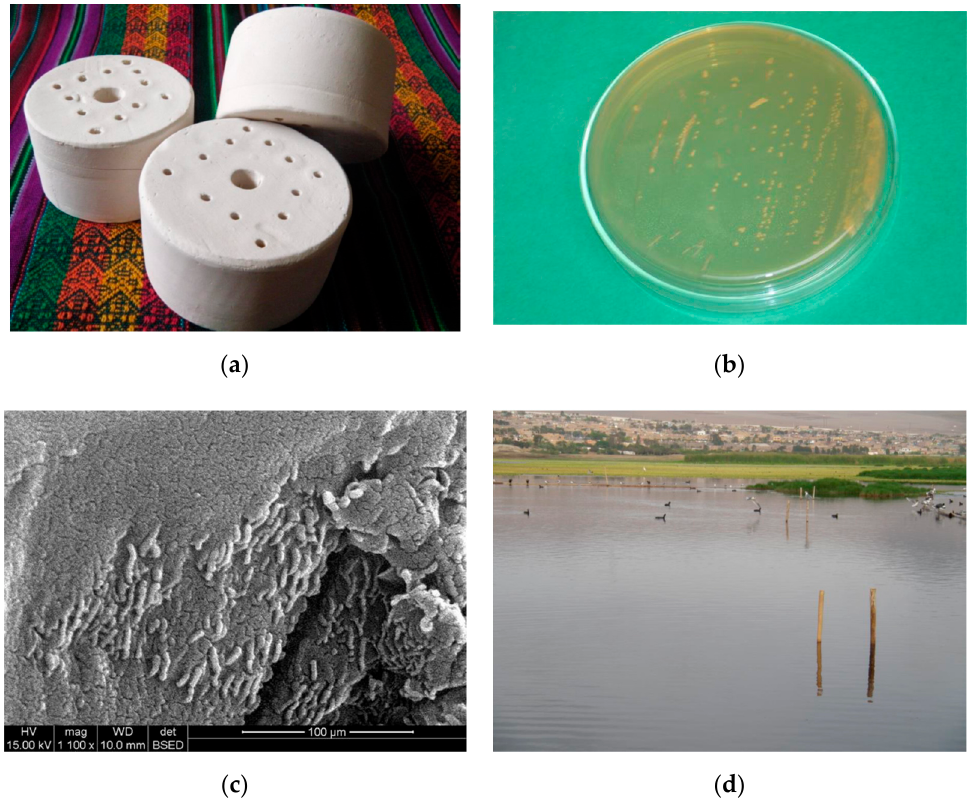
Figure 2. ( a ) Bio-filter made by ceramic cylindrical carrier form; ( b ) Lactobacillus plantarum ATCC 8014 in MRS medium; ( c ) scanning electron microscope (SEM) image of immobilized Lactobacillus plantarum ATCC 8014 on a ceramic carrier; ( d ) picture of bio-filter in the Cascajo Wetlands, placed with the attached eucalyptus sticks.